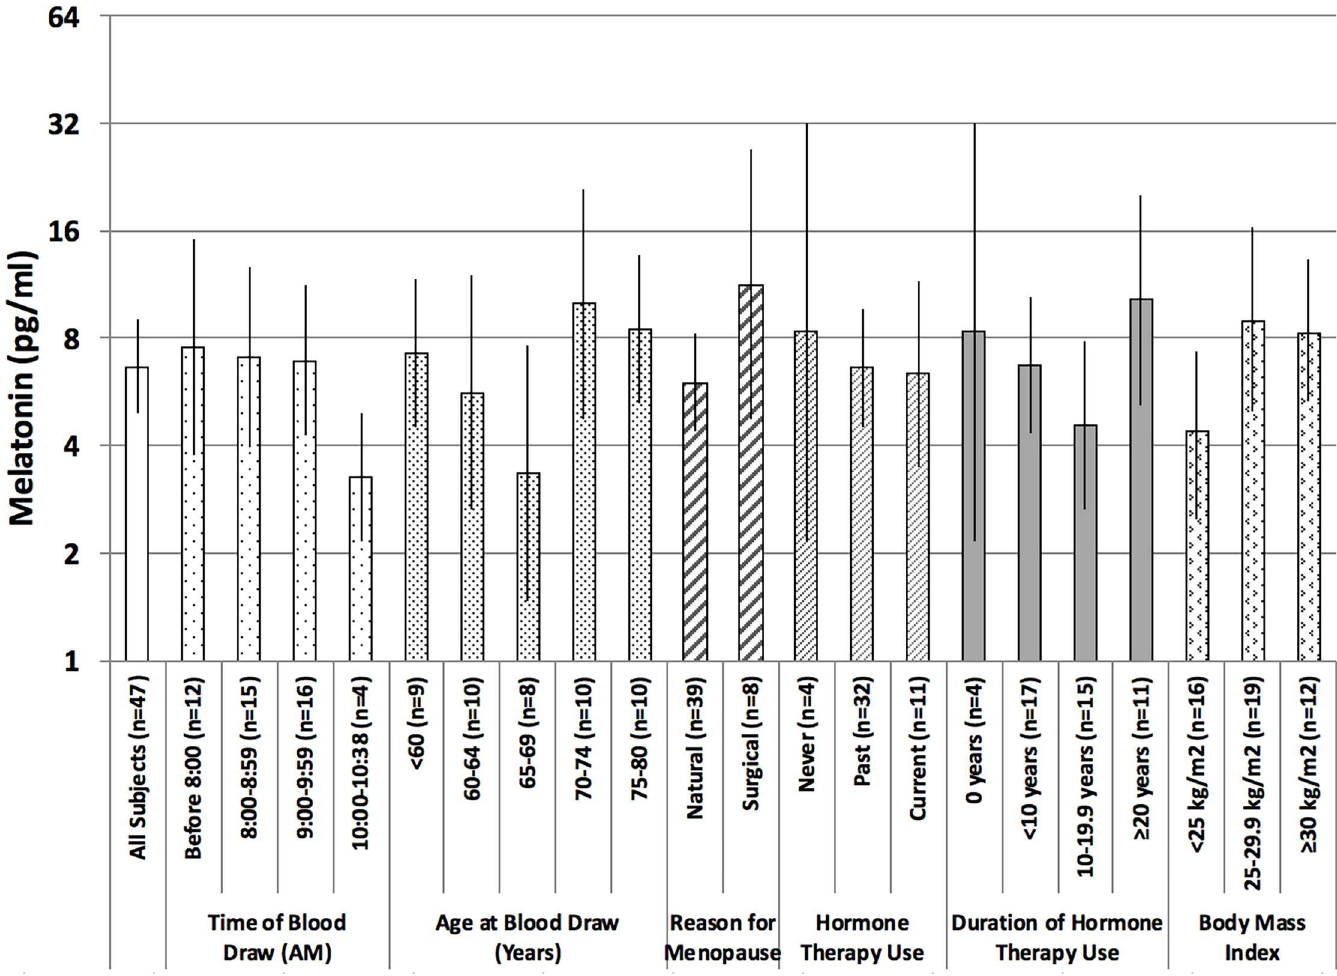
Fig 1. Morning melatonin levels in non-Hispanic white postmenopausal women, stratified by time of blood draw, age group at blood draw, reason for menopause, hormone therapy use, duration of hormone therapy use, and body mass index.